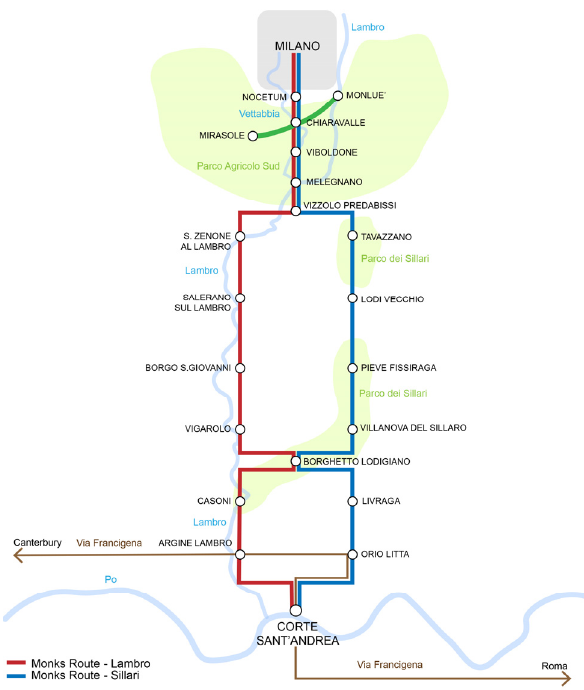
Figure 3. Territorial scheme of the alternative routes: Monks Route - “Lambro”, Monks Route -